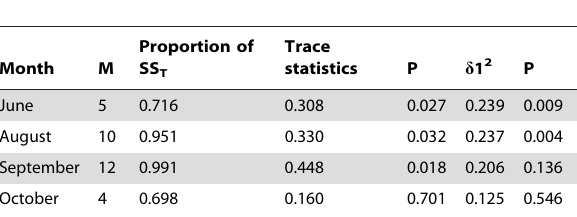
Table 3. Results of the CAP analysis of diet